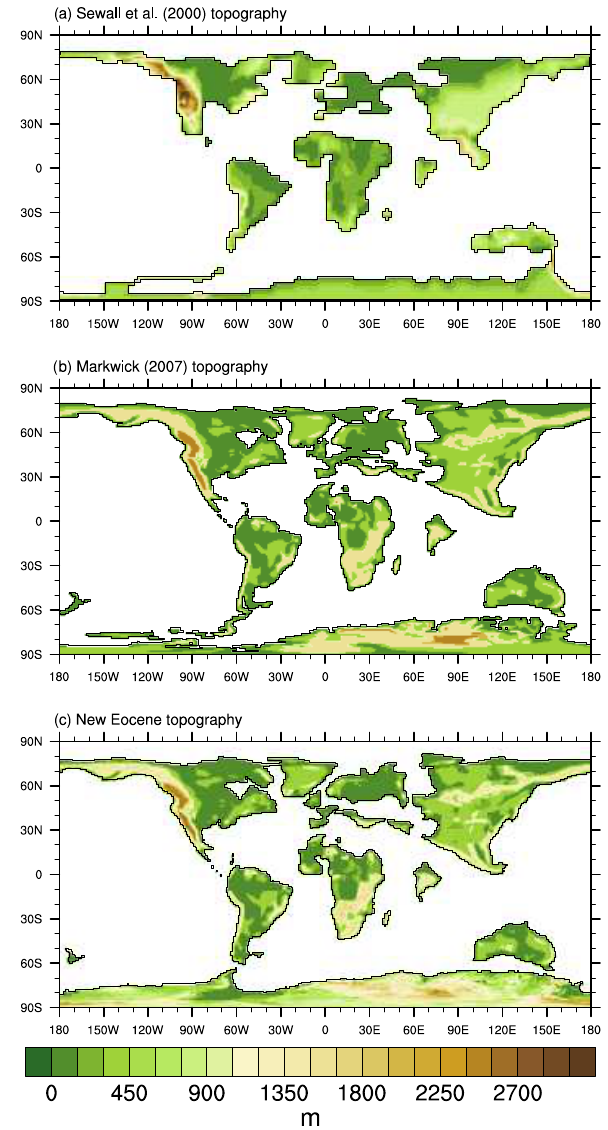
Figure 1. Eocene topography from (a) Sewall et al. (2000), (b) Markwick (2007) and (c) our revised early Eocene topography.